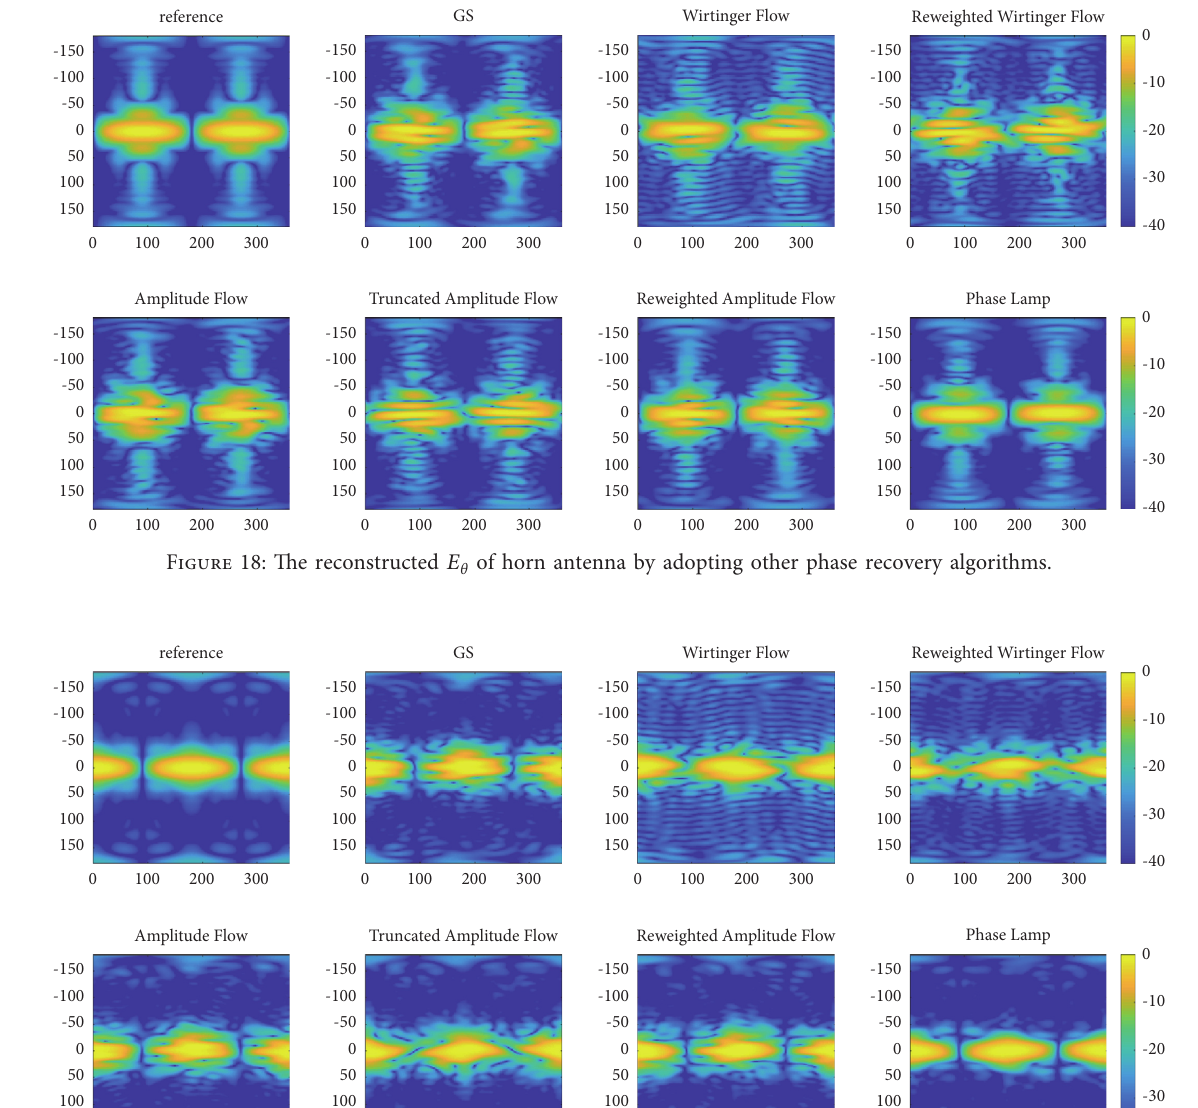
of horn antenna by adopting other phase recovery φ